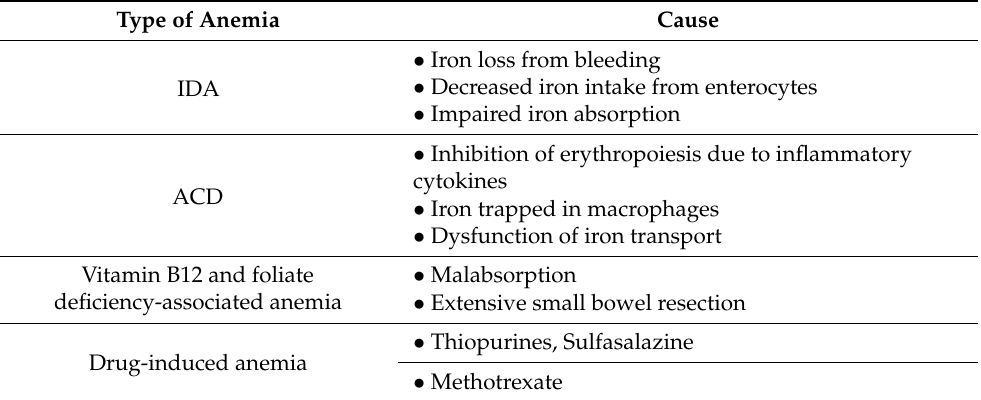
Table 1. Pathogenesis of anemia in IBD patients